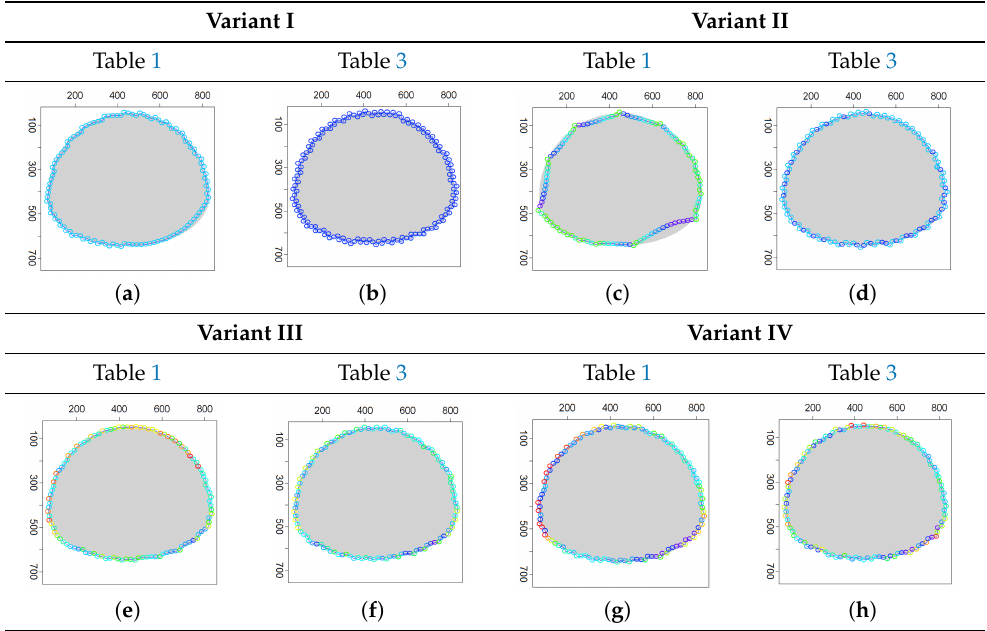
Table 6. Successive D P positions during cloud boundary tracking calculated for two variants of (cid:101) χ m updating procedures and two sets of parameters from Tables 1 and 3; simulation scenario Cloud 3